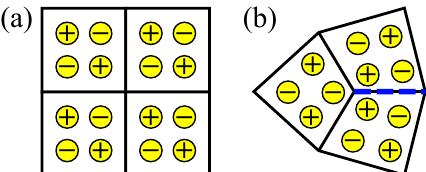
Figure B.1: An internal unitary symmetry or antisymmetry U with U 2 = 1 allows to label the physical degrees of freedom in the unit cell, indicated by the signs ± on the orbitals depicted by yellow circles. In (a), we show a fourfold rotation symmetric lattice in which the representation of fourfold rotation symmetry has to anticommute with the internal unitary symmetry or antisymmetry because the rotation permutes the labels. In (b), we show a disclination that is connected to a domain wall (blue dashed line) between two regions related by a permutation of the